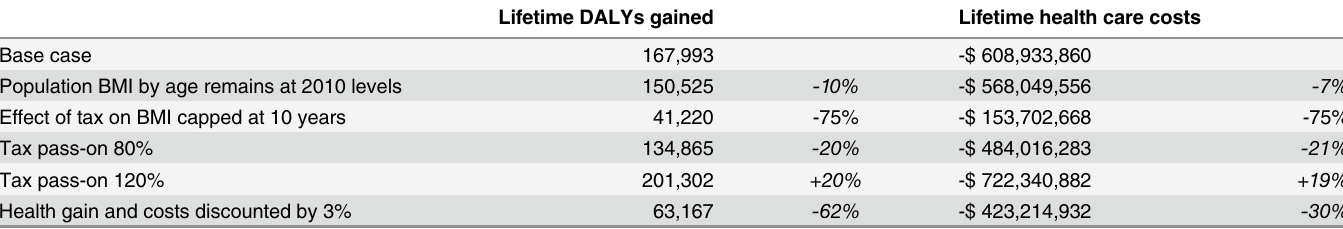
Table 1. Results of the sensitivity